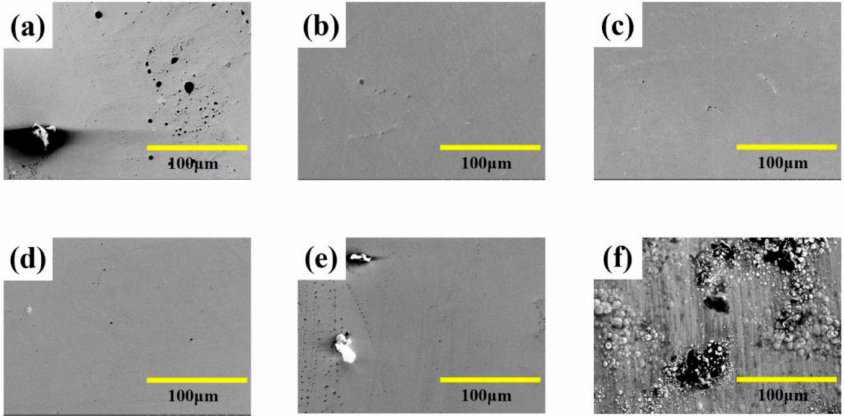
Figure 2. SEM micro-graphs of coatings with varying laser energies at: ( a ) 0 µ J, ( b ) 10.0 µ J, ( c ) 12.5 µ J,